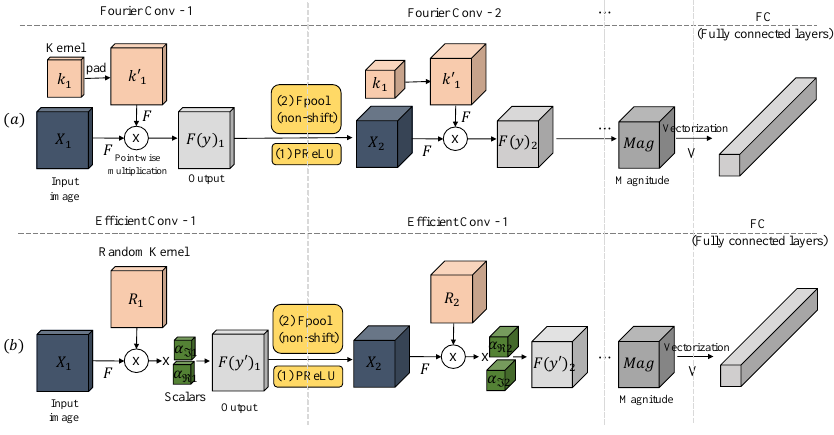
Figure 6. Architectures of presented convolutional neural networks (CNNs) for reducing the number of parameters. ( a ) Proposed Fourier CNN. ( b ) Proposed efficient Fourier